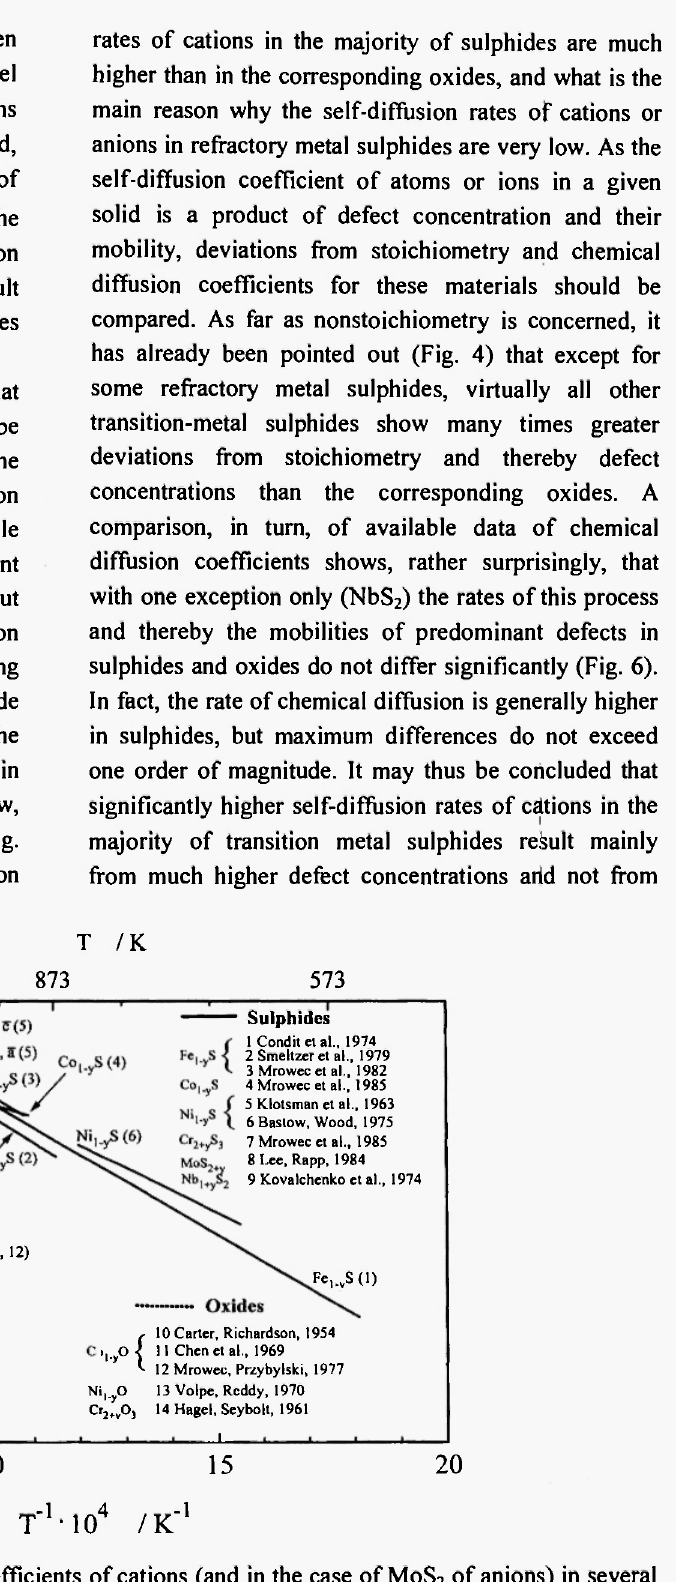
Fig. 5: Temperature dependence of self-diffusion coefficients of cations (and in the case of MoS 2 of anions) in several sulphides and